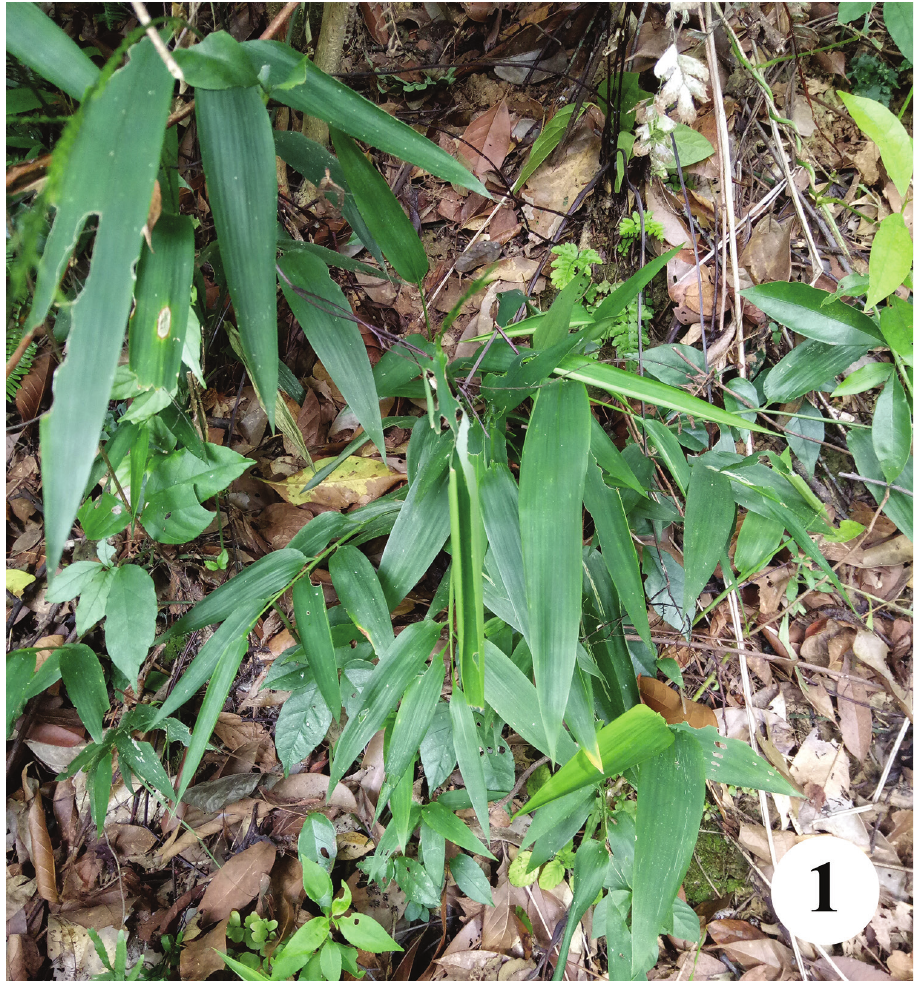
Figure 1. Lophatherum gracile , host plant of Asprothrips atermaculosus sp. n.